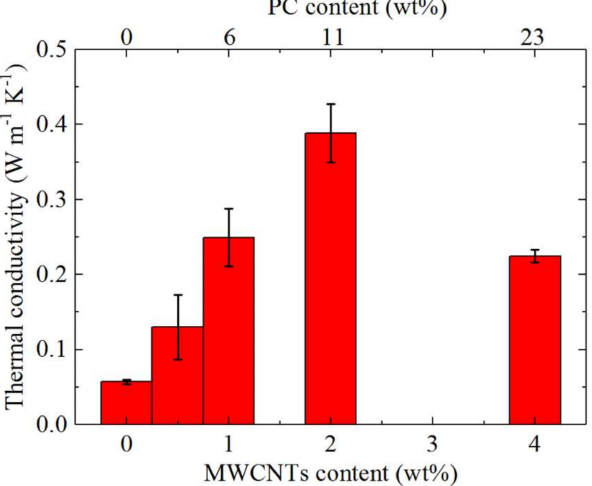
Figure 14. Influence of MWCNTs content on the thermal conductivities of the nanocomposites. The PC content is indicated in the top